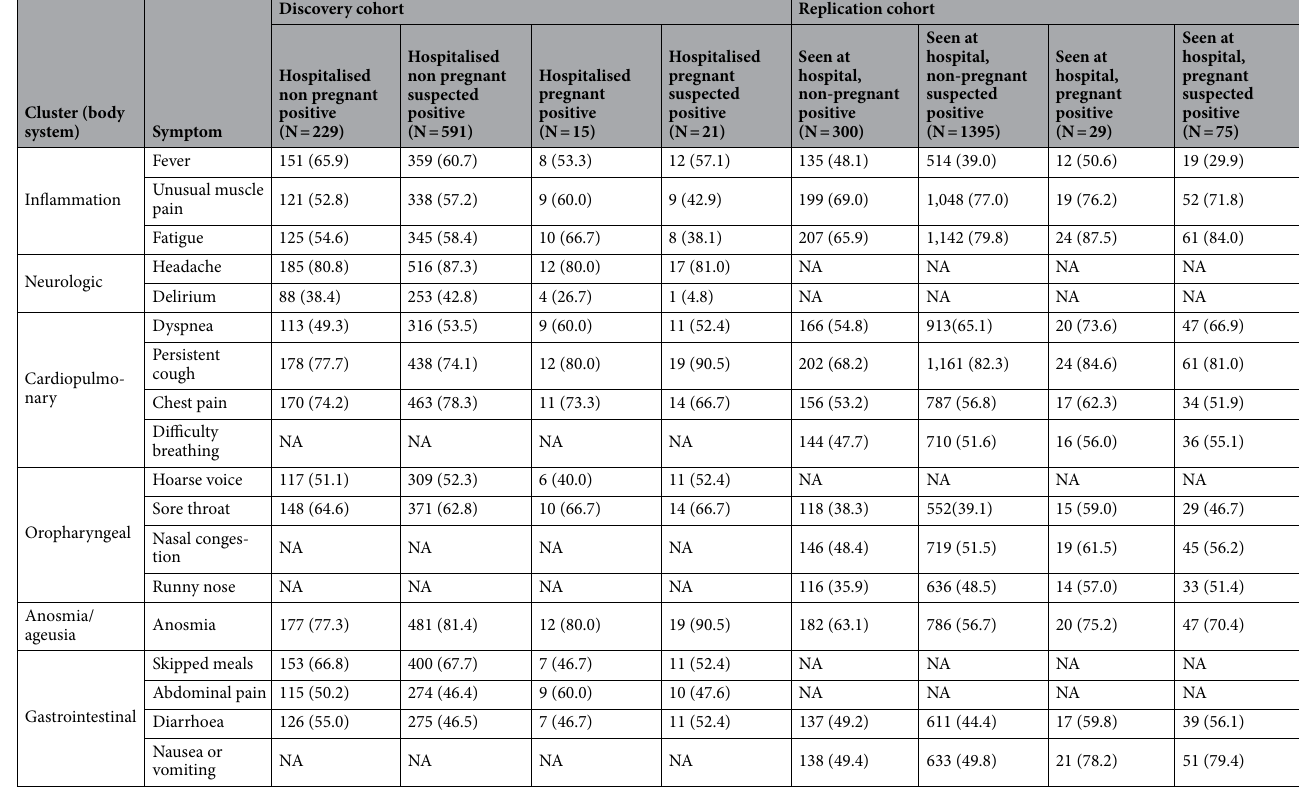
Table 2. Frequencies and percentage values of presentation of each symptom among hospitalized in the discovery cohort, and among all women who self-reported being seen at a hospital for their illness in the replication cohort (as hospitalization data were not available). Data are reported by pregnancy status and further subdivided by SARS-CoV-2 test positive or suspected COVID-19 status. Data are reported as N (%) in the discovery cohort, and N surveys (survey-weight adjusted %) in the replication cohort. Fatigue was mapped to tiredness/exhaustion and unusual muscle pain to pain in muscle and joints in the replication cohort. Symptoms not ascertained or mapped in either cohort are marked as not available